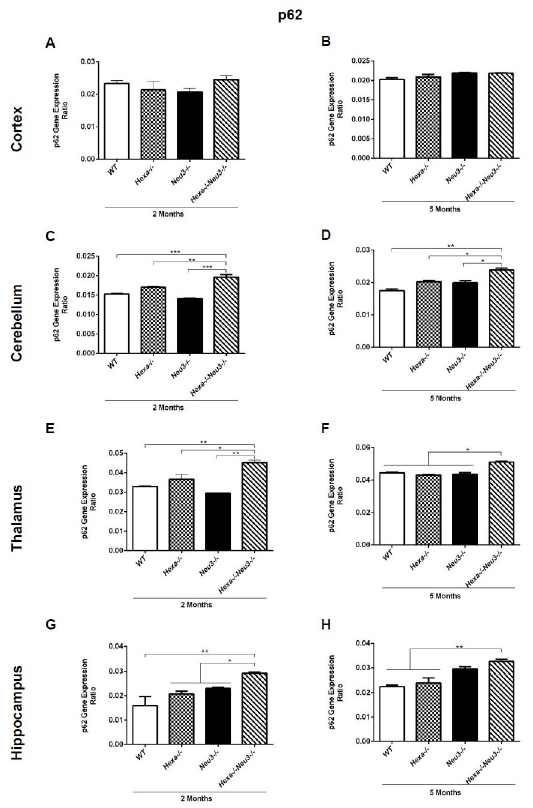
Fig 6. p62 gene expression levels of the cortex (A, B), cerebellum (C, D), thalamus (E, F), and hippocampus (G, H) of 2- and 5-month-old WT , Hexa-/- , Neu3-/- , Hexa-/-Neu3-/- mice. Expression was calculated by the Δ CT method and percent ratios were represented. One-way ANOVA analysis was used to determine p-values via GraphPad. Data are reported as mean ± SEM (n = 3; � p < 0,05, �� p < 0,025, ��� p <